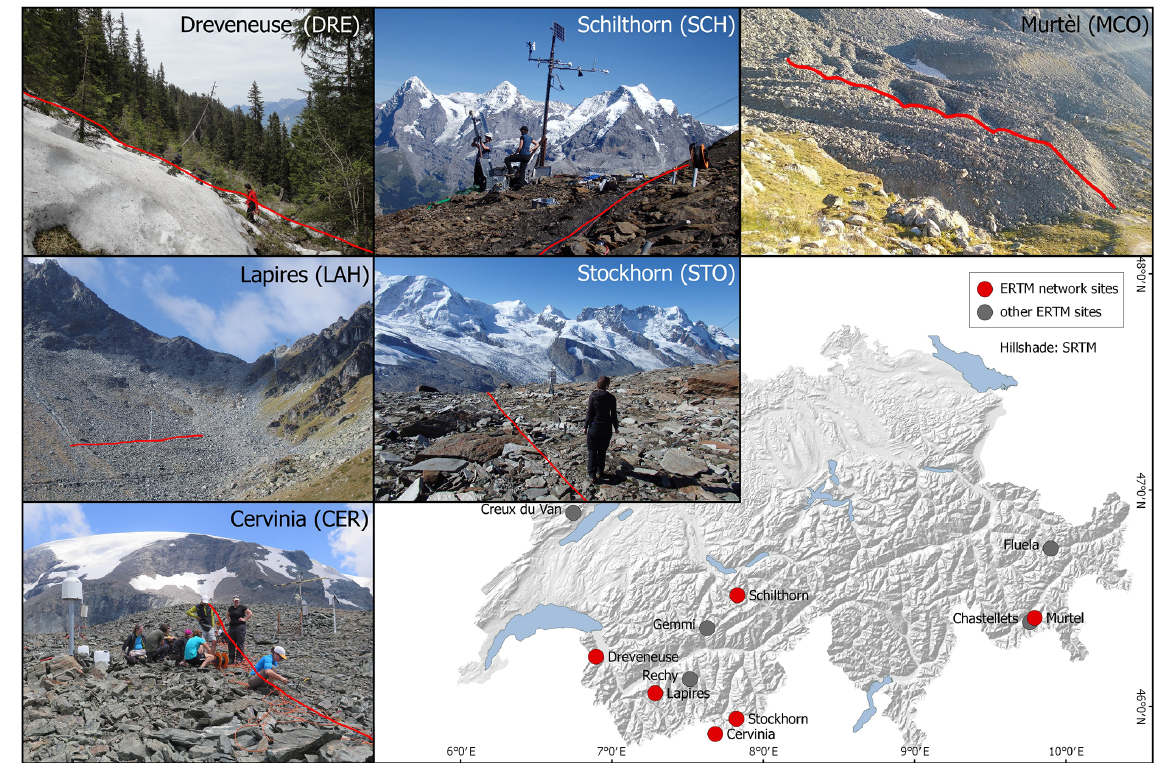
Figure 1. Map of Switzerland with location of the ERTM network sites presented in this paper (in red) and other monitoring sites (in grey). Photographs show the location of the ERT profiles in red for each site of the network. Note that CER is located in